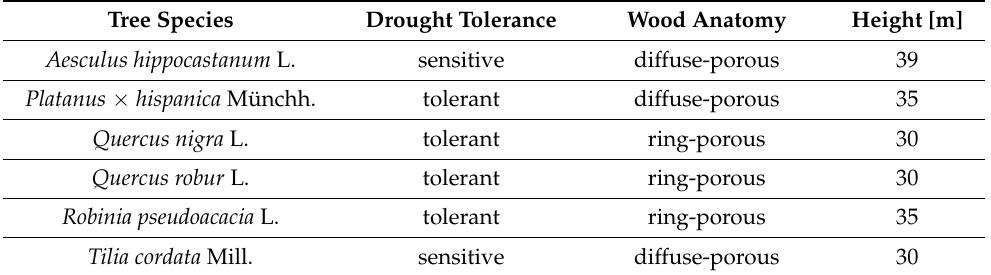
Table 2. Description of sampled tree species and their characteristics on drought tolerance (following Niinemets & Valladares, 2006), wood anatomy, and maximal achievable height. Tree Species Drought Tolerance Wood Anatomy Height [m] Aesculus hippocastanum L. sensitive diffuse-porous 39 Platanus × hispanica Münchh. tolerant diffuse-porous 35 Quercus nigra L. tolerant ring-porous 30 Quercus robur L. tolerant ring-porous 30 Robinia pseudoacacia L. tolerant ring-porous 35 Tilia cordata Mill. sensitive diffuse-porous